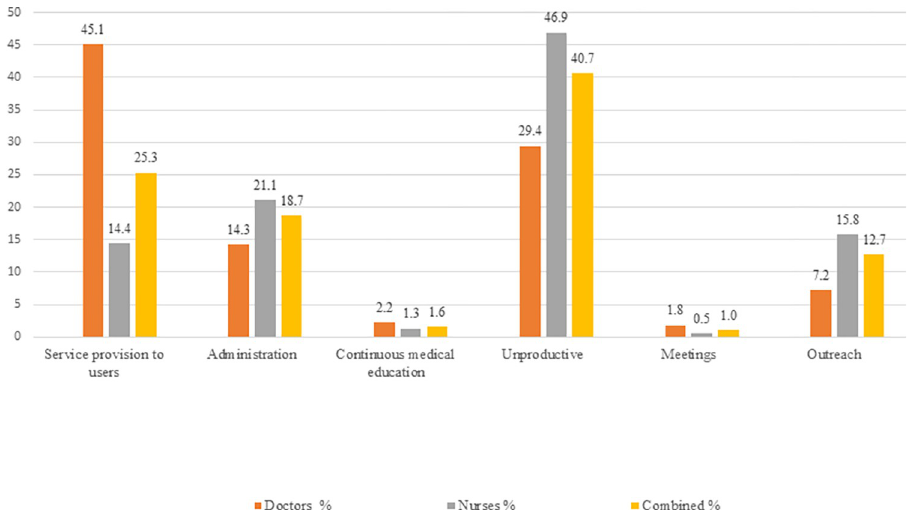
Fig 2. Percentage of overall time allocation on categories of